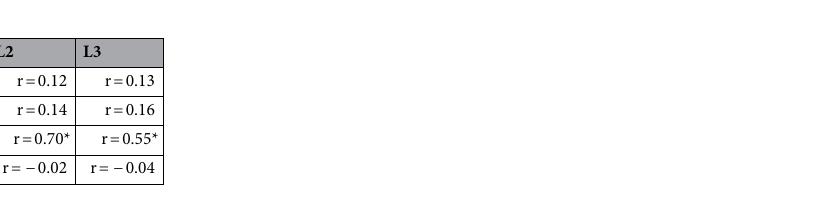
Table 1. Pearson correlations between 4 characteristic frequency bands of ECRS EEG and learning indices. *P <